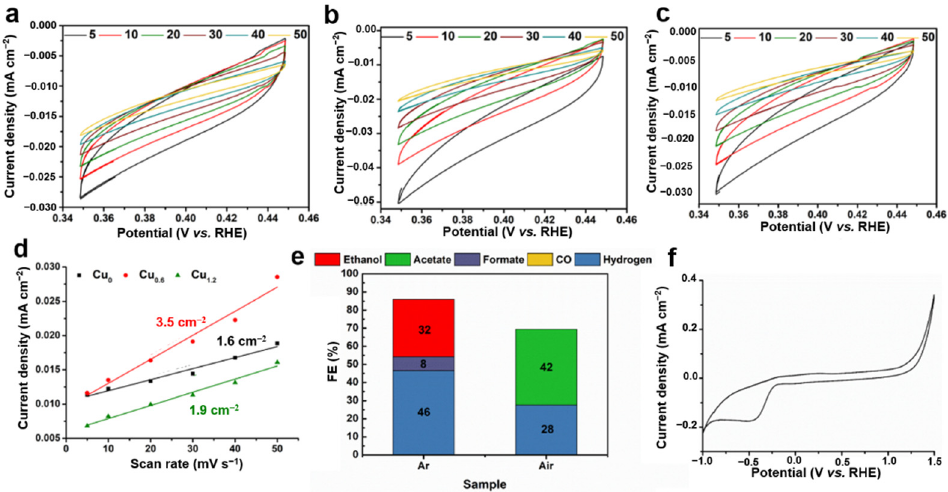
Figure 13. ECSA for ( a ) Cu 0 , ( b ) Cu 0.6 , ( c ) Cu 1.2 , and the electrochemical surface area for ( d ) Cu 0 (black), Cu 0.6 (red), and Cu 1.2 (green). FE of the CO 2 RR products for Cu 0.6 post-treated under different atmospheres at − 0.6 V vs. RHE ( e ). CV of Cu 0.6 post-treated in air at 150 °C for 6 h as the anode ( f ).